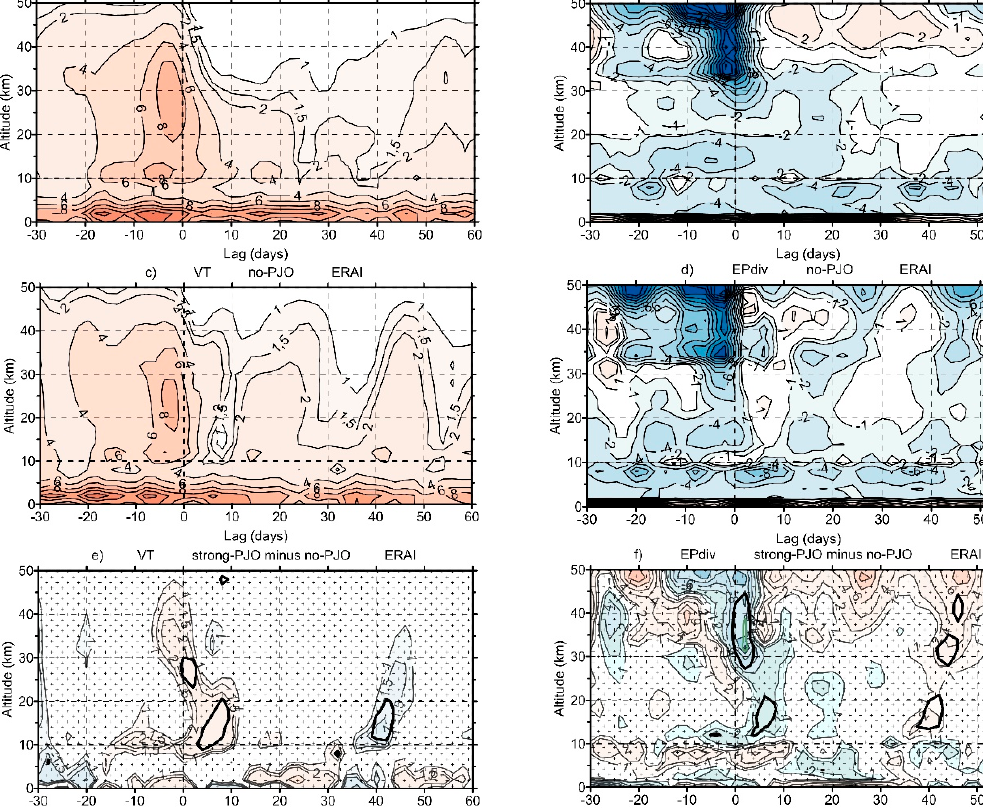
Figure 4. ERA ‐ Interim: Altitude ‐ time cross ‐ sections of zonal mean eddy heat flux ( a,c ; K m/s), and of mean EP ‐ flux divergence ( b,d ; 1/day) for strong ‐ PJO ( a,c ) and non ‐ PJO ( b,d ); panel ( e ) for heat flux and ( f ) for EP ‐ flux divergence show the difference of strong ‐ PJO minus non ‐ PJO composite, respectively. The mean is taken over a latitudinal belt from 50 ◦ –70 ◦ N. Heat flux values are divided by (p/ 1000 hPa). Hatched areas ( e , f ) are statistically insignificant. Area enclosed by thick black lines are statistically significant (95% confidence level). Dashed lines mark CD (vertical) and approximated tropopause (horizontal). The standard transformed Eulerian mean diagnostics based on quasi-geostrophic approximation is calculated according to References [2,38].